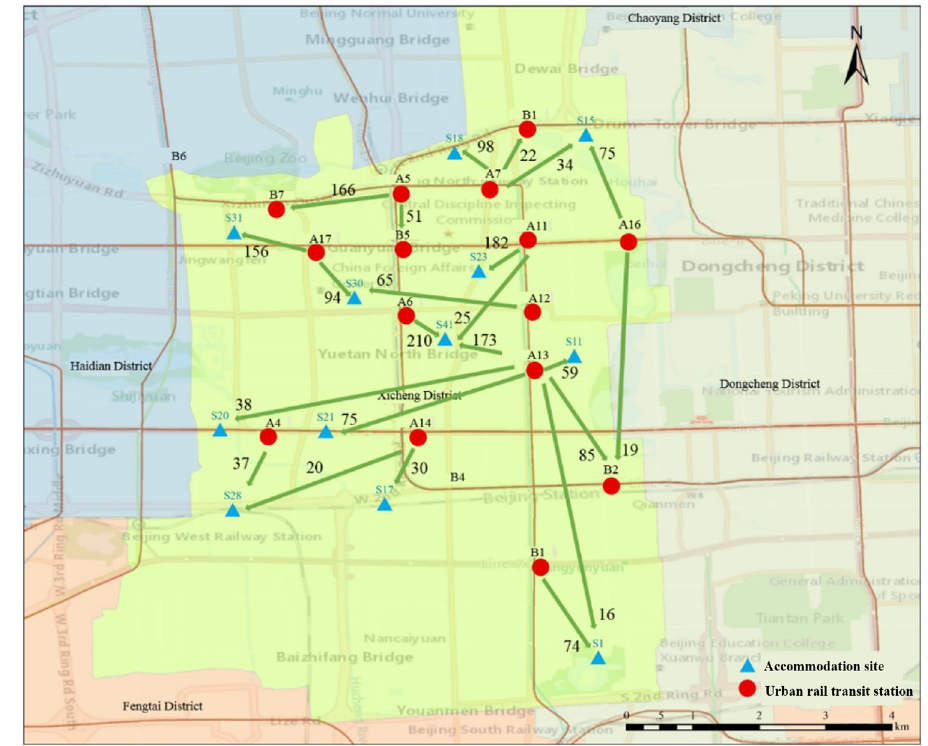
Fig. 9 Deployment schematic diagram of export stations